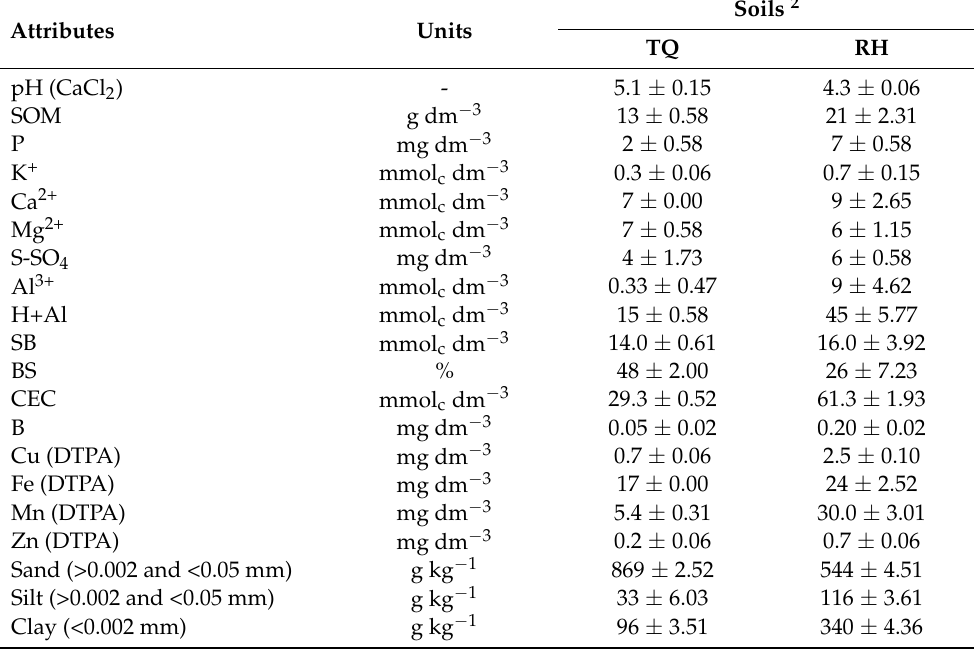
Table 1. Chemical and physical attributes 1 of soil samples used in the experiment (Mean ± standard deviation; n =